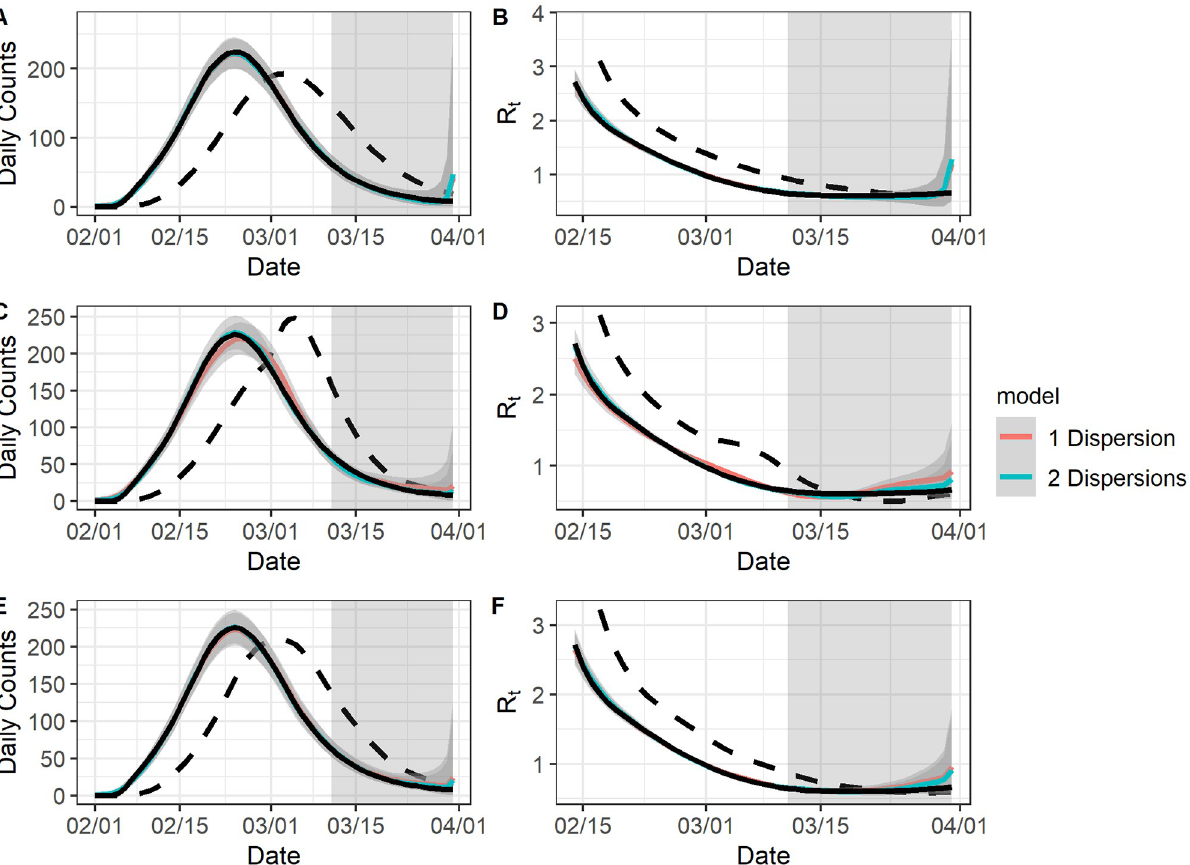
Fig 2. The model fit for complete data. For all graphs: the black solid curve corresponds to estimates based on the known epidemic curves and the black dashed curve corresponds to estimates based on the reported curves. The grey-shaded region superimposed on the curve depicts the 95% Bayesian credible interval and the grey-shade region on the right indicates the region of nowcasting. The colored curves represent different model choices. All values were averaged over 1000 simulated datasets with the correct l . A: The epidemic curve estimates if the reporting delay distribution was unchanged. B: The reproduction number estimates if the reporting delay distribution was unchanged. C: The epidemic curve estimates if the reporting delay distribution was sharply improved. D: The reproduction number estimates if the reporting delay distribution was sharply improved. E: The epidemic curve estimates if the reporting delay distribution was gradually improved. F: The reproduction number estimates if the reporting delay distribution was gradually improved.